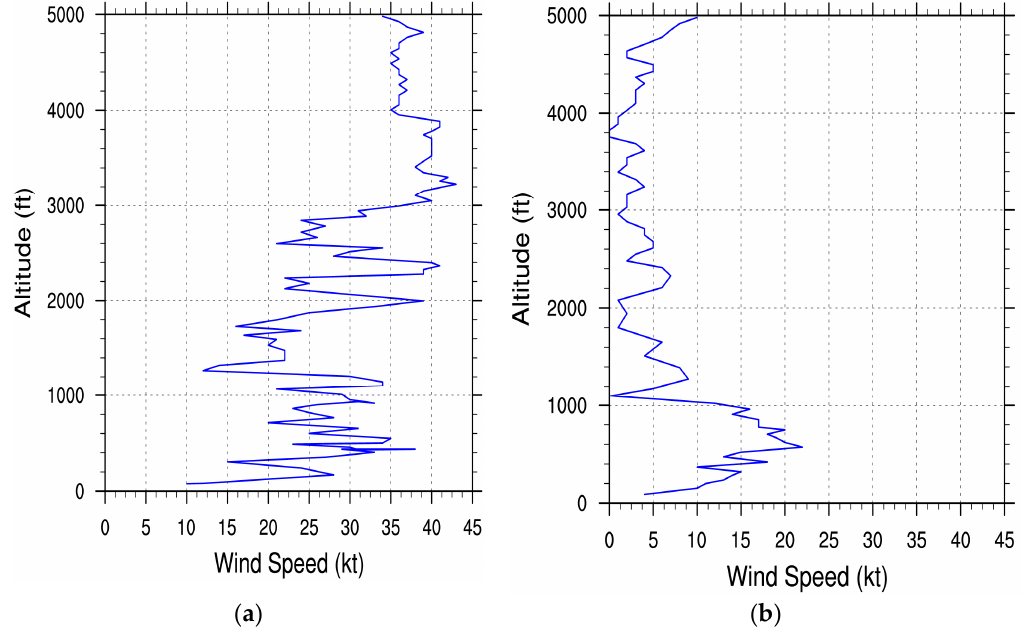
Figure 4. Variation of wind speed with altitude along the flight path, below 5000 ft (1524 m), for: ( a ) Flight 1; ( b ) Flight 2.